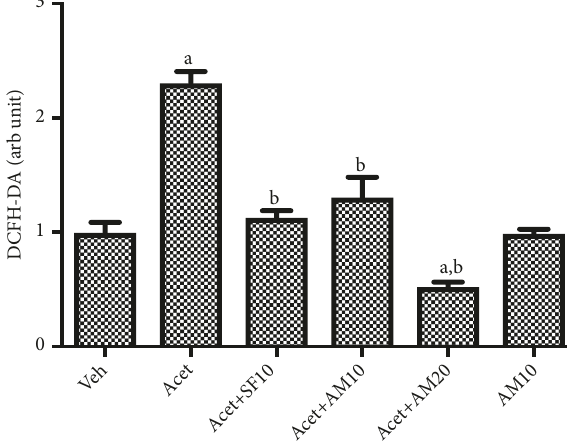
Figure 9: Intracellular ROS in LX-2 cells were treated with alpha mangostin with or without acetaldehyde induction. Results were presented as mean ± SEM. a: p < 0.05 versus untreated group, b: p < 0.05 versus acetaldehyde group. Veh: vehicle only, Acet: acetalde- alpha mangostin 10 𝜇